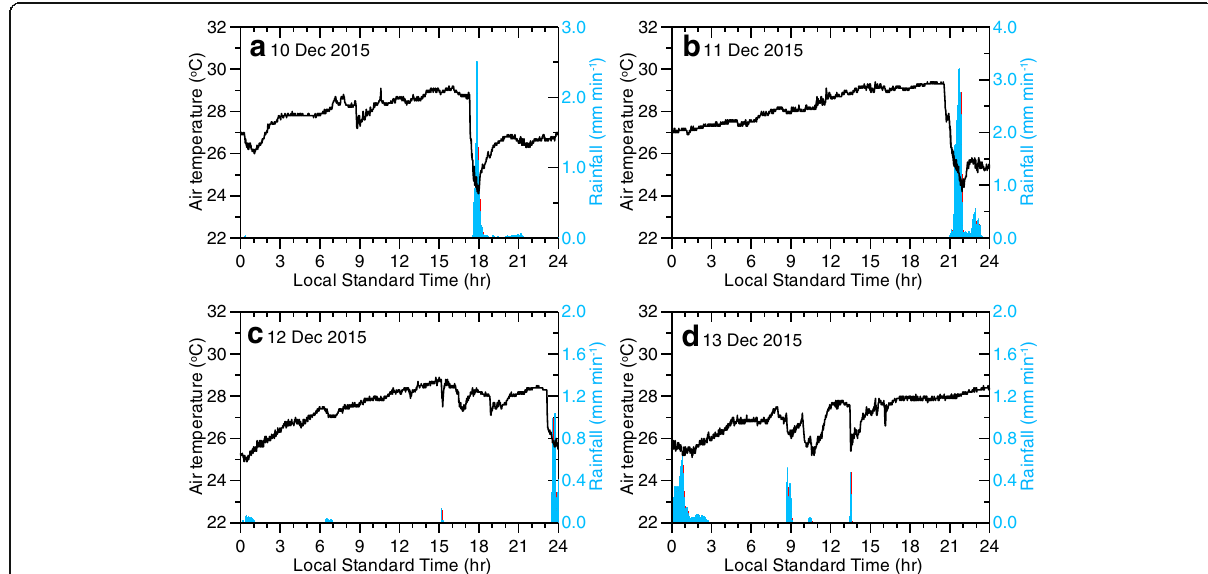
Fig. 5 Time series of surface air temperature and precipitation off the western coast of Sumatra Island observed by the research vessel Mirai for four consecutive days from a ) 10, b ) 11, c ) 12 and d ) 13 December 2015 at intervals of 1 min